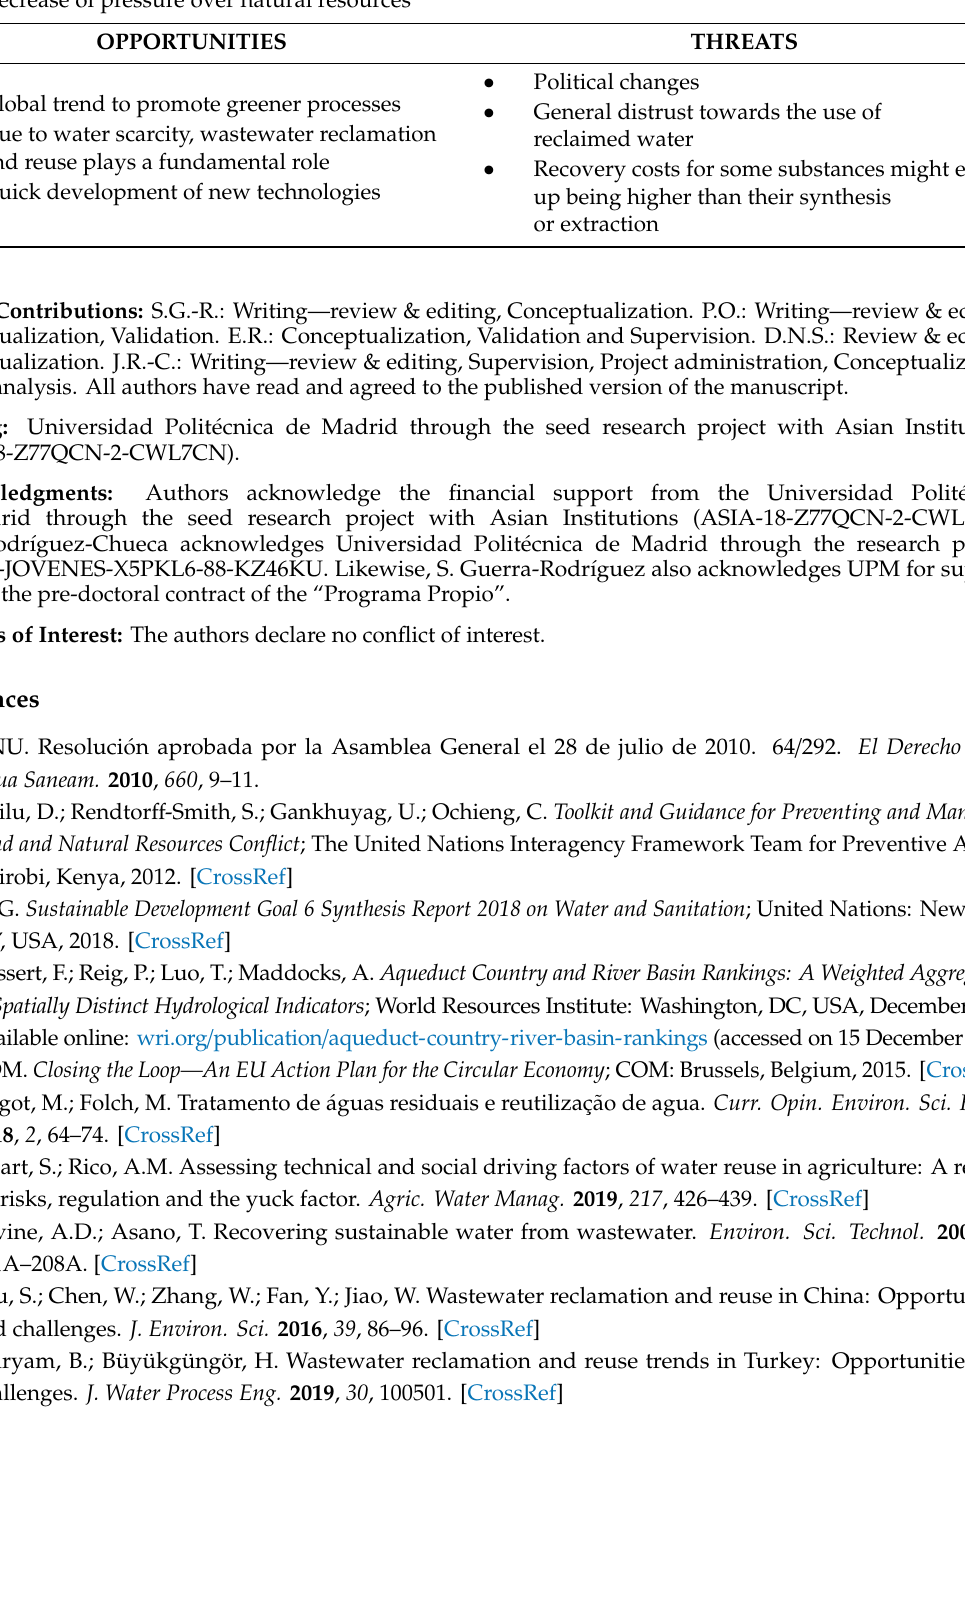
Little experience in large-scale implementation Decrease of pressure over natural resources OPPORTUNITIES THREATS Political changes • General distrust towards the use of